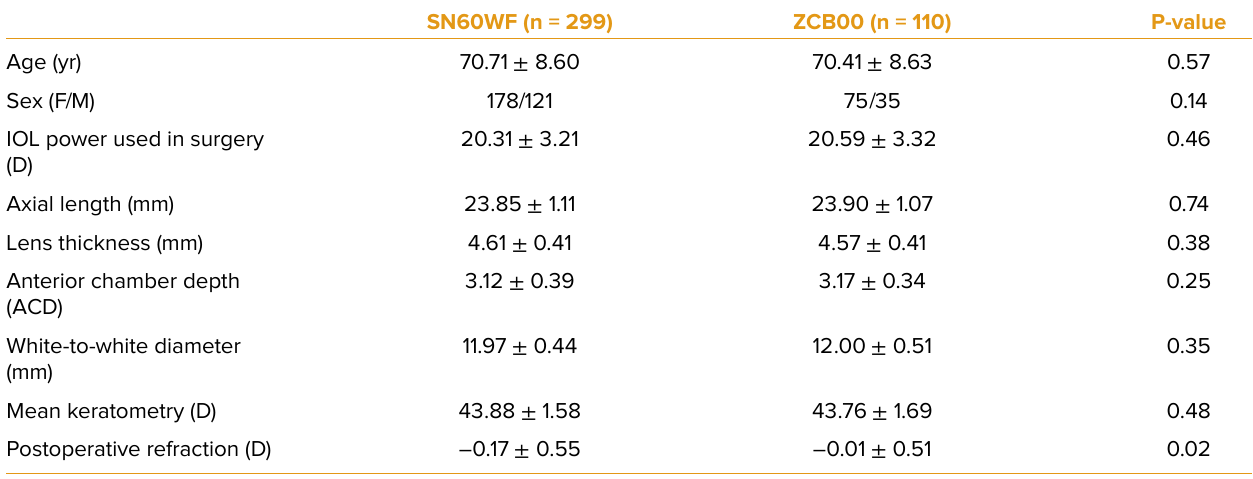
Table 1. Patient demographics and ocular biometric values for eyes with SN60WF and ZCB00 lenses.